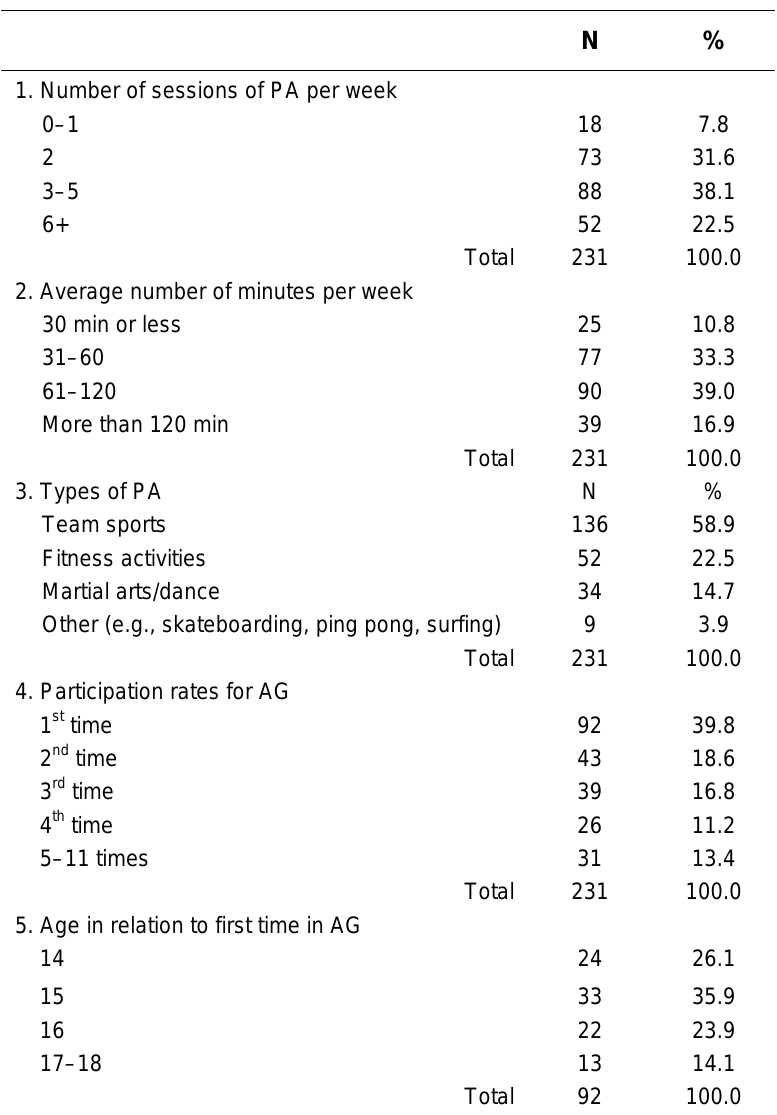
Physical Activity